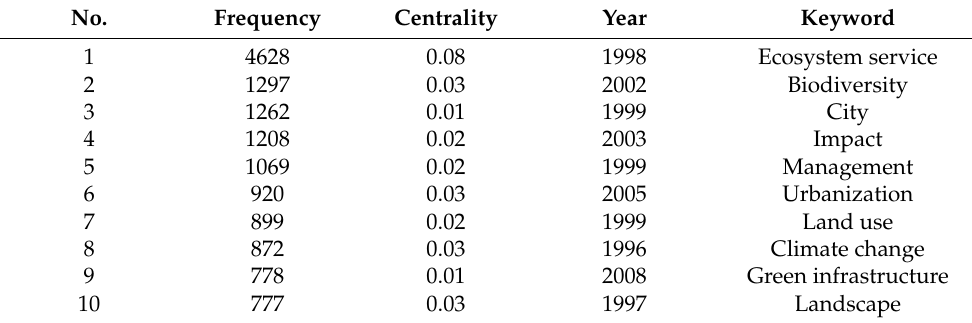
Table 8. List of keyword co-occurrence.